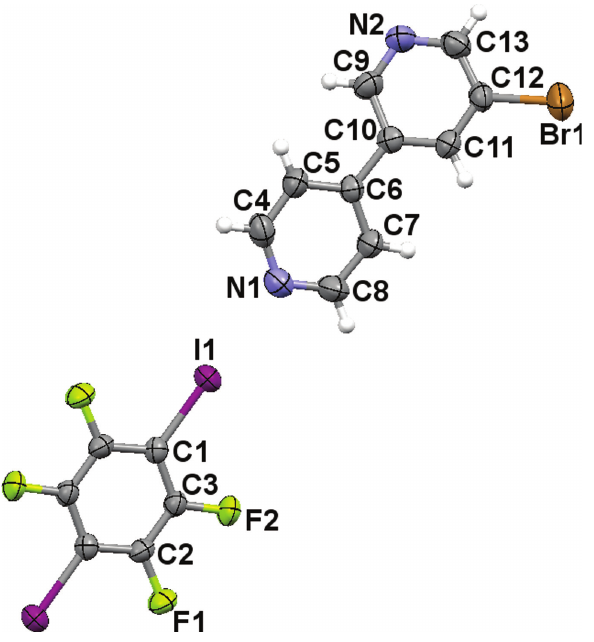
Figure 1: Molecular structure of the title complex with dispalcement ellipsoids draw at the 50% proability level.